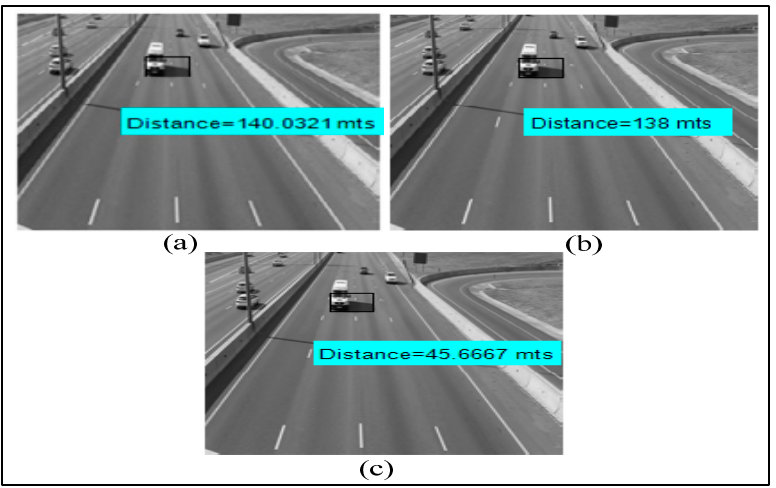
Figure 14. Emergency vehicle detection process: ( a ) RGB frame; ( b ) Grayscale frame; ( c ) Difference